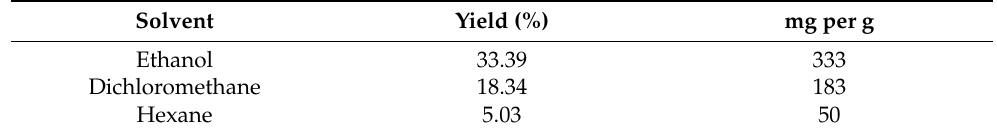
Table 1. Percentage yield from organic extracts of S. graminifolia leaves (100